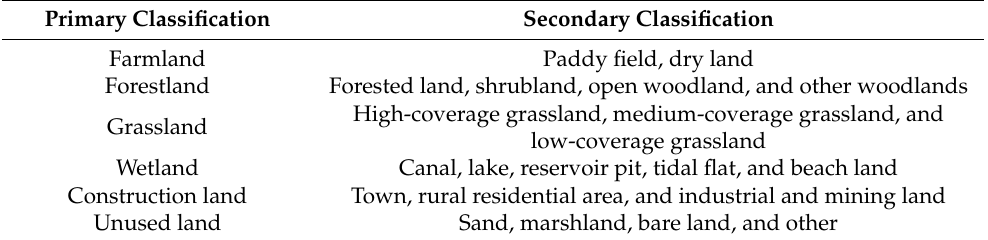
Table 1. Land-use classification system for the Guangdong–Hong Kong–Macao Greater Bay Area